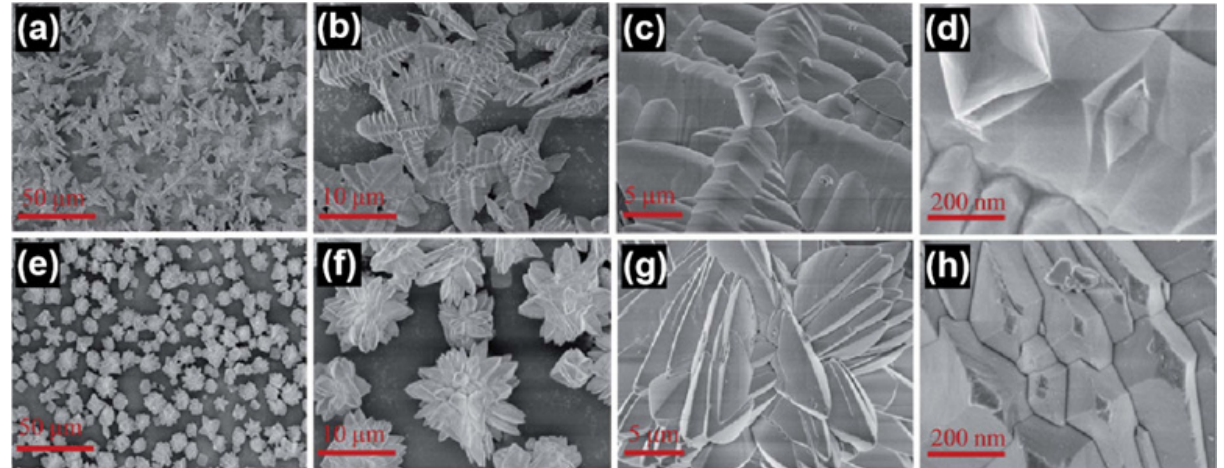
Figure 5: SEM images of branch-like (A-D), flower-like (E-H) FePO 4